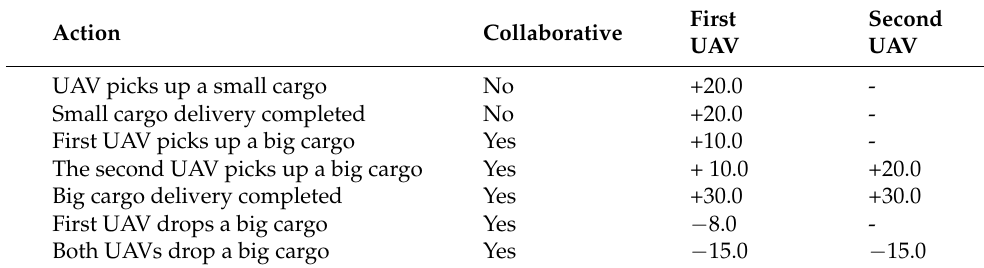
Table 3. Summary of delivery rewards.